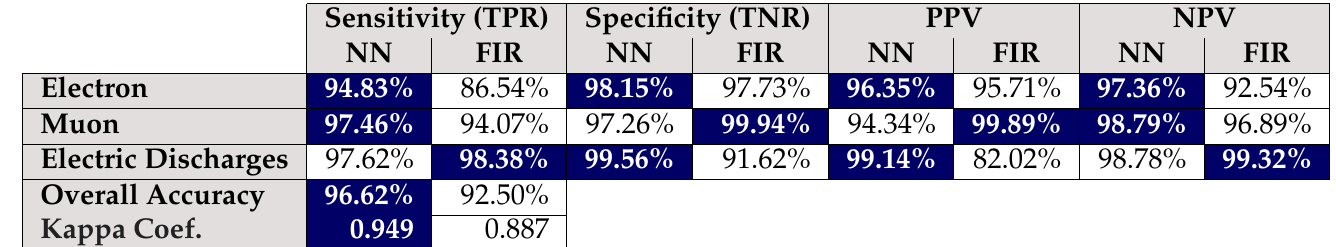
Table 4. Sensitivity, specificity, positive and negative predicted value comparison between the neural network and FIR.